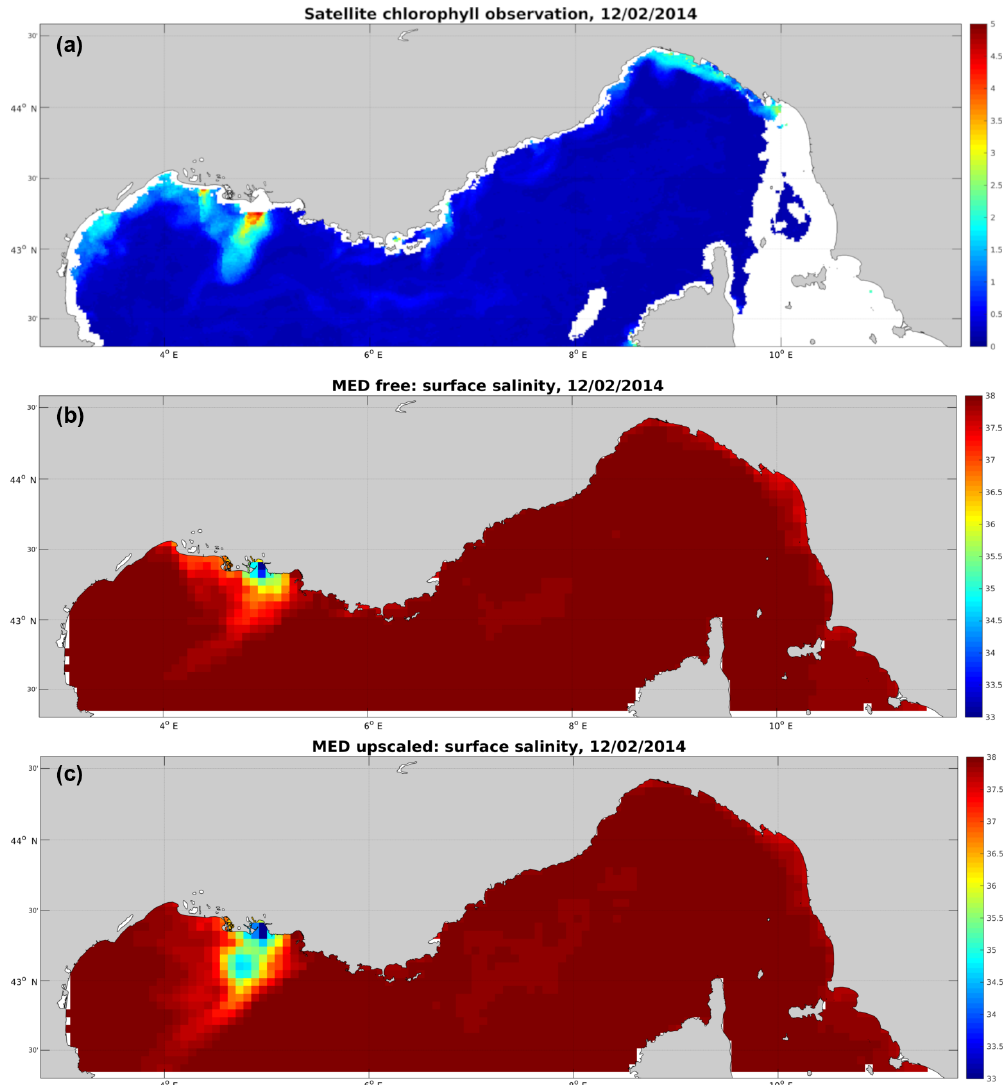
Figure 9. Comparison of the Rhône River plume on 12 February 2014: (a) satellite chlorophyll image, (b) free parent model salinity (c) and upscaled parent model